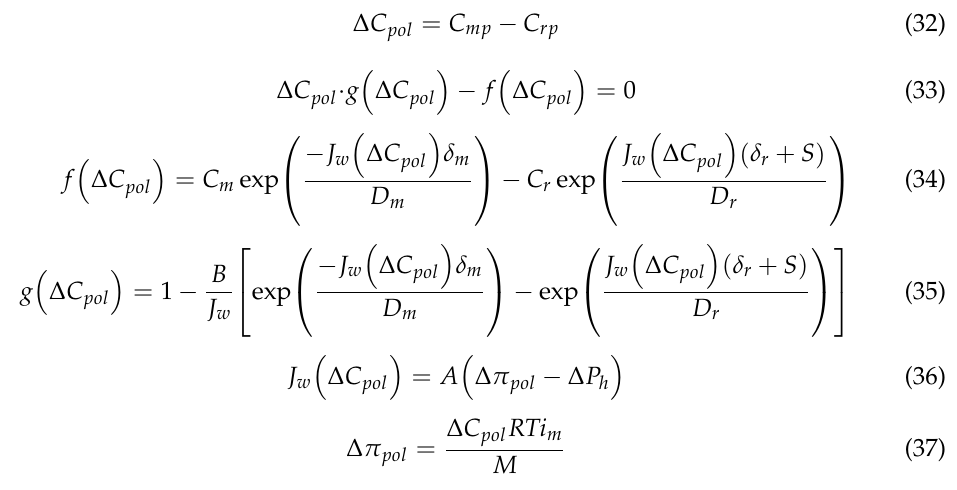
Figure 5. Salinity polarization inside the membrane module. The values of C mp and C rp , however, are not known in advance; hence, the effective salinity gradient ∆ C pol must be estimated from the solution of the non-linear Equation (cid:16) (cid:17) (cid:16) (cid:17) ∆ C ∆ C (33), where g and f are the functions given by (34) and (35). According pol pol to (28) and (29), the water permeate flux J w depends on the salinity gradient through the membrane surfaces. Arguably, due to the polarization phenomenon, that salinity gradient must be considered as ∆ C pol instead of the ideal one ∆ C . Thus, in (34) and (35) J w is expressed as the function of ∆ C pol given by (36), where ∆ π pol and ∆ P h are given by (37) and (38), respectively. In these equations, S , δ j , and D j represent the membrane structure parameter, the thickness of the salinity increasing and decreasing zones (see Figure 5), and the salt diffusion coefficient (for j = r,m ), which are detailed in [23]. In addition, B is the salt permeability coefficient, whereas C r , C m , R , T , i m , and M are those previously denoted for (27) and (28). Once ∆ C pol is obtained from the solution of (33), the river water permeate flux J w , the osmotic pressure ∆ π pol , the hydraulic pressure ∆ P h , and the salt permeate flux J salt can be evaluated from (36), (37), (38), and (39),